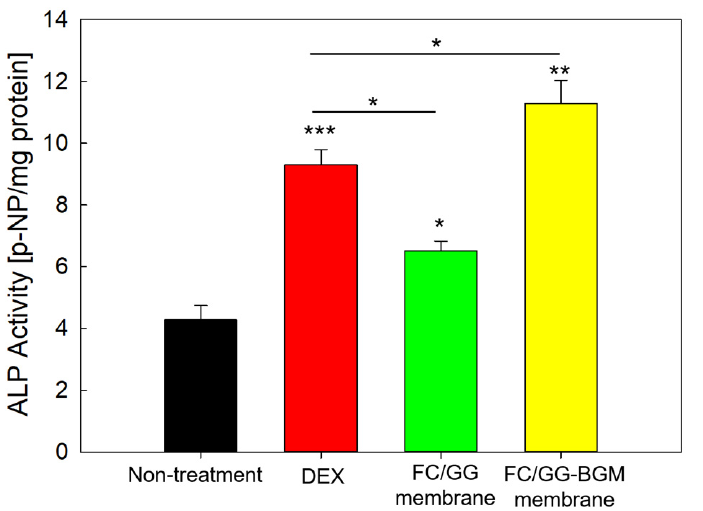
Figure 7. ALP activity of MC3T3-E1 cells cultured on FC/GG membranes and FC/GG-BGM mem- branes for 14 days (* p < 0.05, ** p < 0.01, *** p < 0.001). DEX means dexamethasone and was used as a positive control.